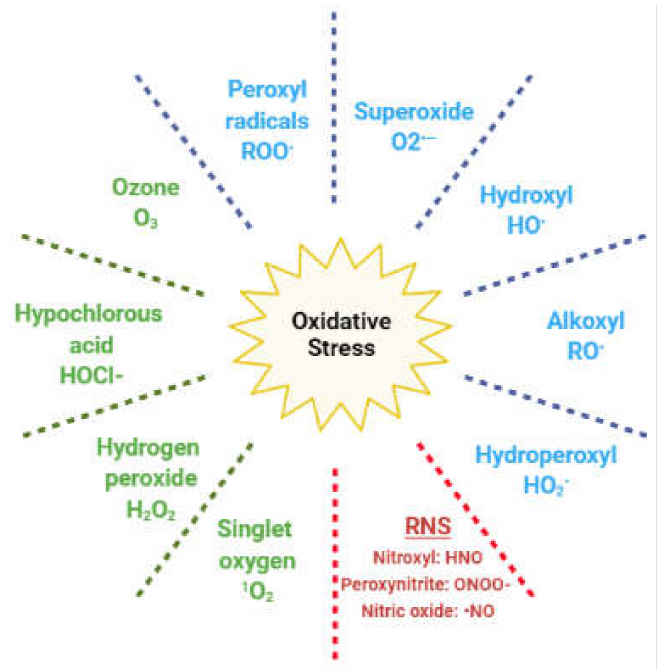
Figure 2. Reactive species responsible for oxidative stress. In blue: radical oxygen species; in green: nonradical oxygen species; in red: reactive nitrogen species